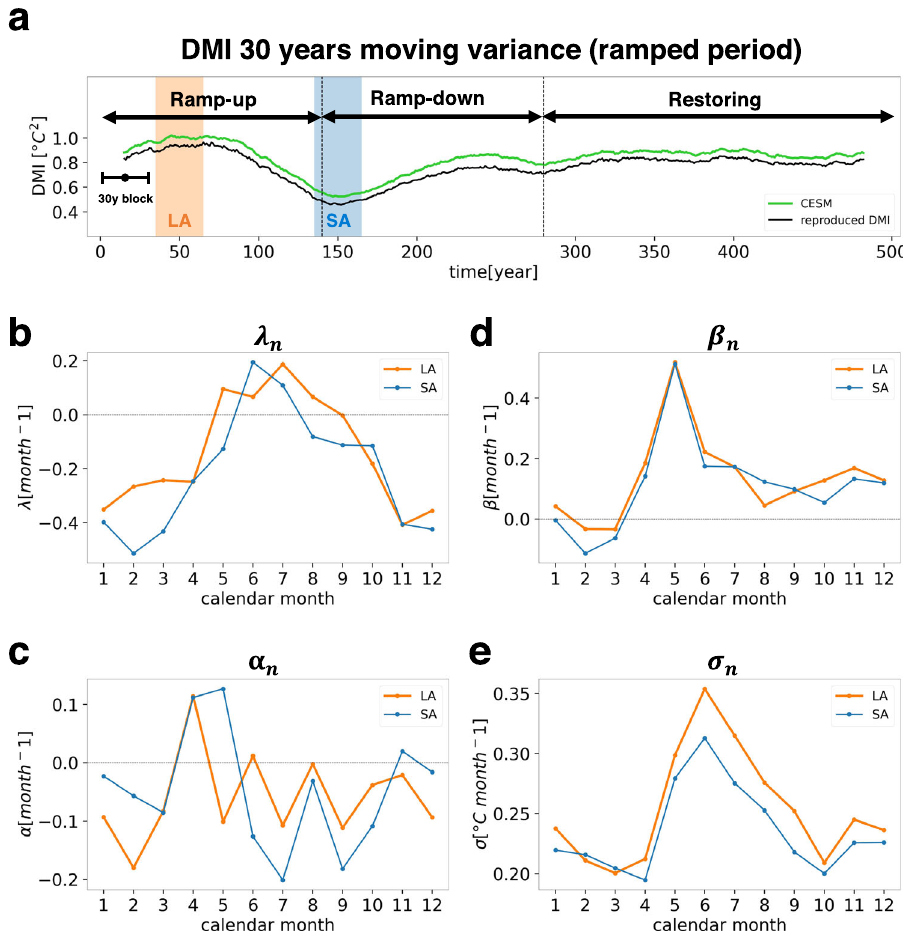
Fig. 3 Parameters for large and small IOD amplitude periods. a Timeseries of 30-year moving variance of DMI anomaly for CDR-reversibility simulations obtained by the CESM1.2 (green) and the simple IOD model (black). Units are °C 2 . b Climatological values of parameter λ n obtained from LA (orange contour) and SA (light-blue contour) from the CDR-reversibility simulations of CESM1.2. c – e are the same as b except for α n , β n , and σ n , respectively. Units for parameters are (month) − 1 . LA and SA periods are marked in a as orange and light-blue bars,